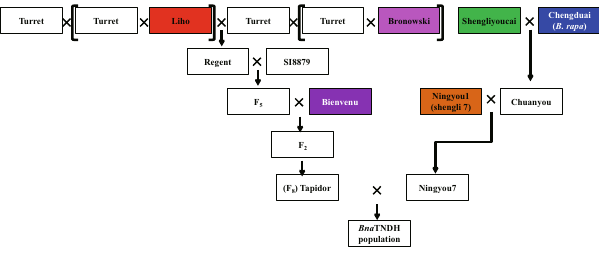
Figure 1. Schematic of genetic transfer in the pedigrees of cultivars Tapidor and Ningyou7. Cultivars Regent, Bienvenu, Liho and Bronowski are ancestors of cultivar Tapidor, with all cultivars developed in European countries or Canada. Cultivars Ningyou1, Chuanyou2, Shengliyoucai and Chengduai are ancestors of cultivar Ningyou7, which were all bred in Asian countries and most in China. Of these, cultivar Chengduai is Brassica rapa (A genome), and the remainder are Brassica napus (AC genome). The Bna TNDH population is derived from a cross between homozygous lines derived from cultivars Tapidor and